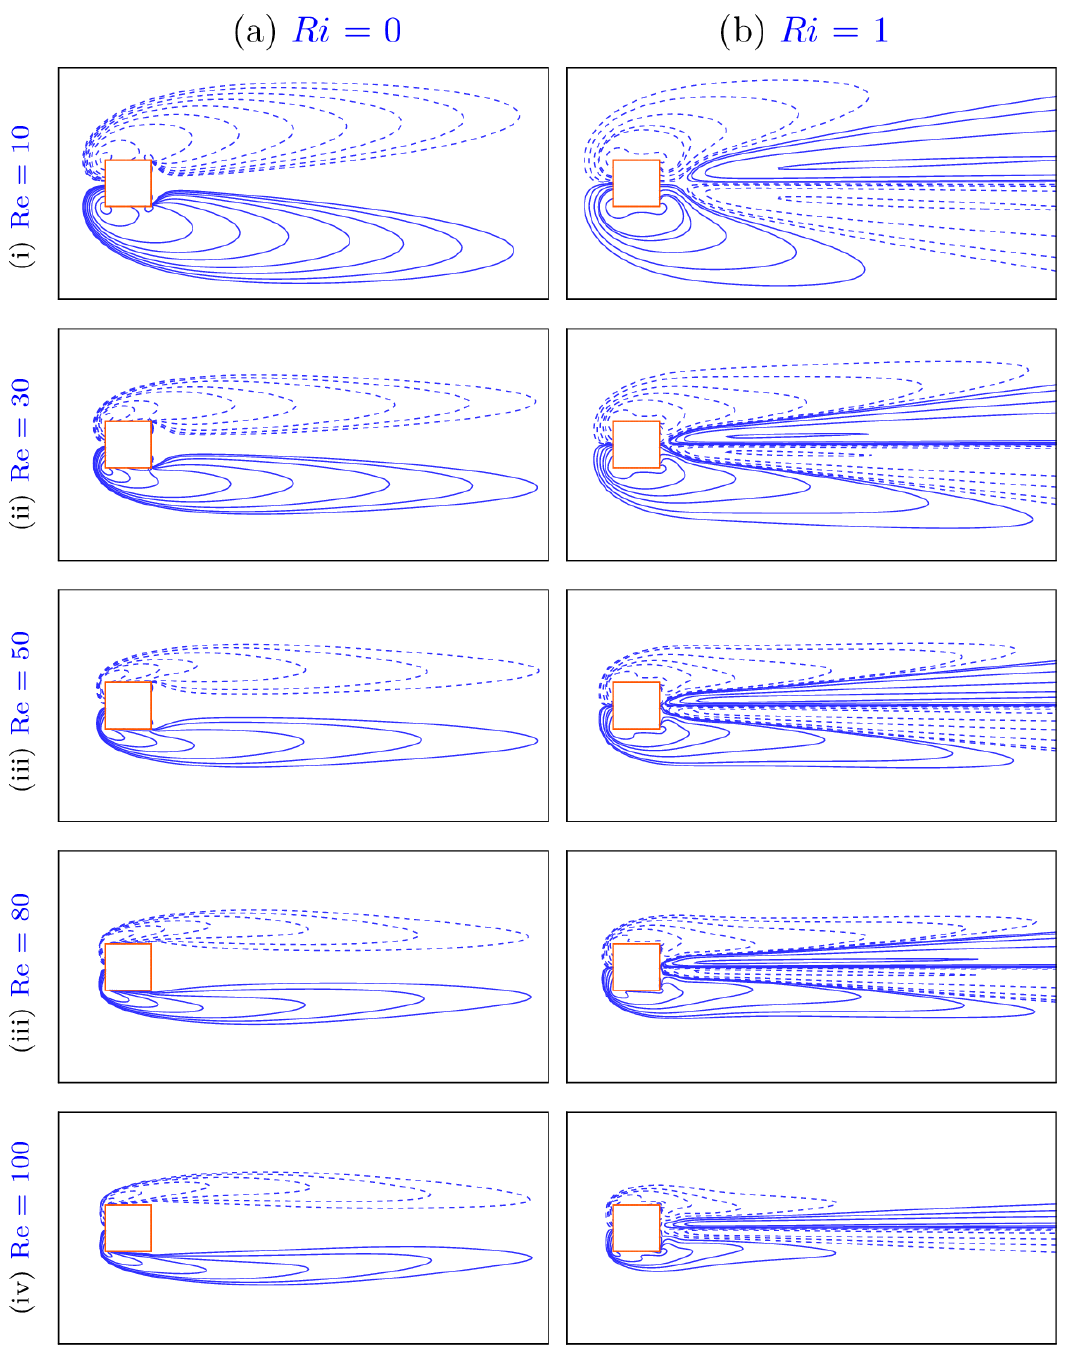
Figure 6. Time-averaged vorticity contours for different values of Re at φ = 5% and Ri ; ( a ) 0 and ( b ) 1.